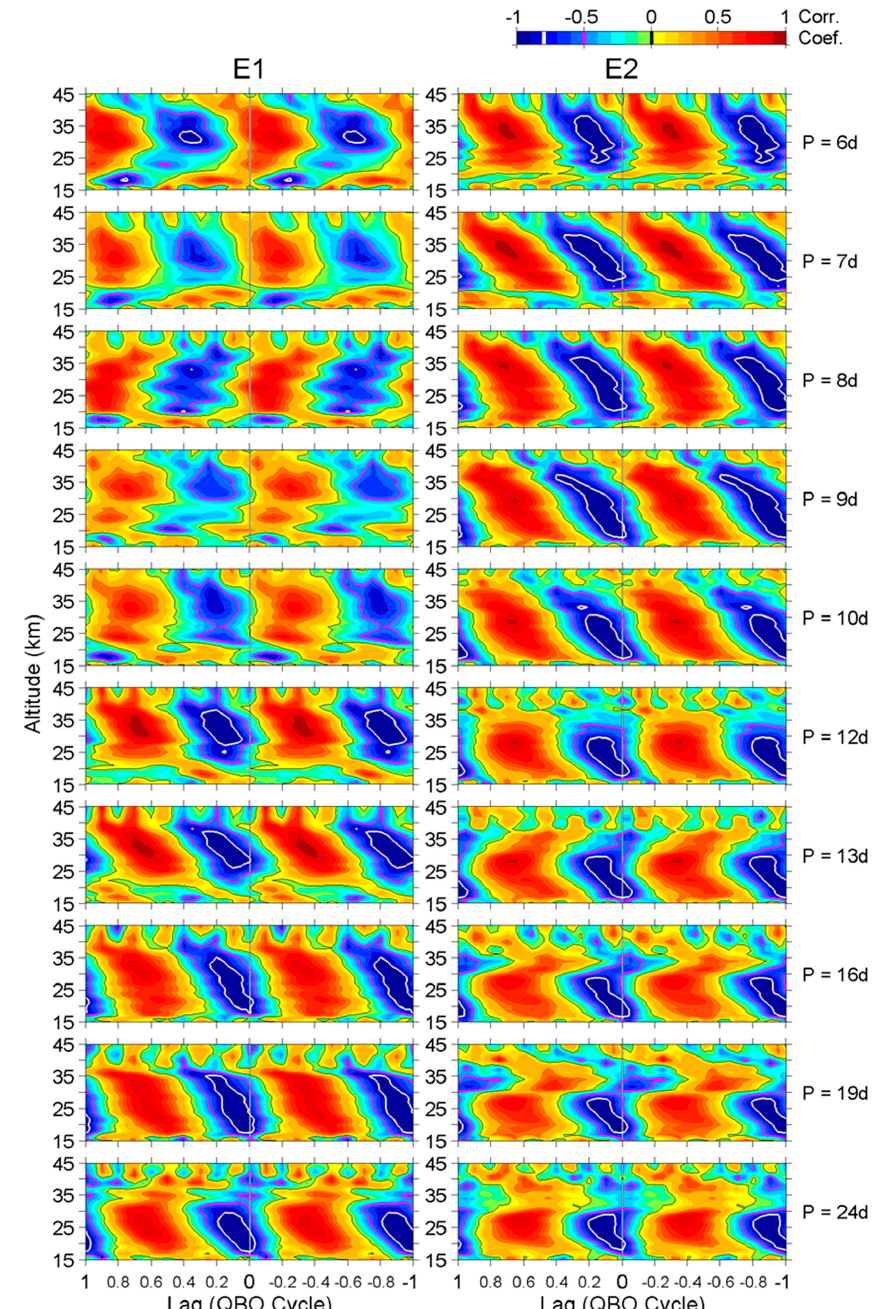
Figure 7. The linear cross correlation coe ffi cients between the time-averaged zonal wind and the wave amplitudes in a layout that is similar to Figure 6. Black, magenta, and white lines circle regions where the correlation coe ffi cient is less than 0, − 0.5, and − 0.8, respectively. Gray lines indicate zero